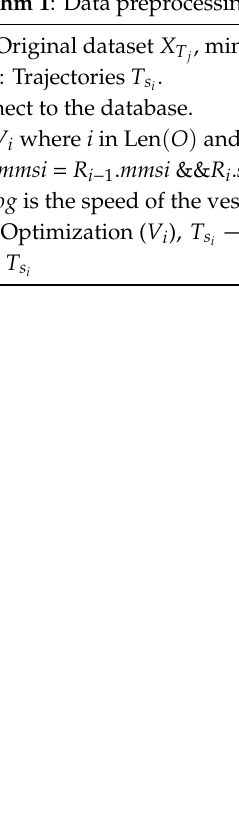
Figure 2. A visualization of the original AIS data in Zhangzhou, Fujian, China. The green line indicates the trajectory, and darker color indicates greater trajectory density. For example, the red area indicates the area with a large trajectory density.